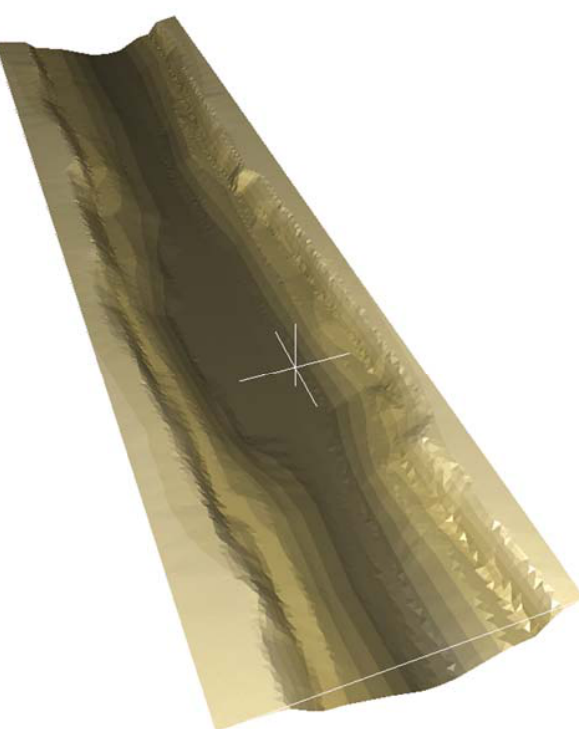
Figure 6. Bed elevation three-dimensional view of the 2-D hypo- thetical example.